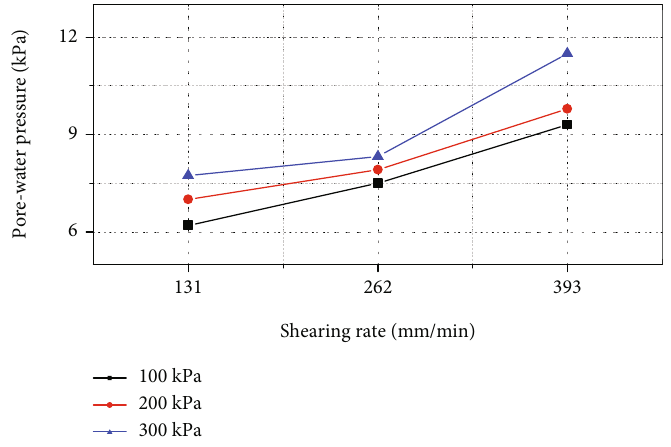
Figure 9: Shearing rate versus pore-water pressure after the shear was